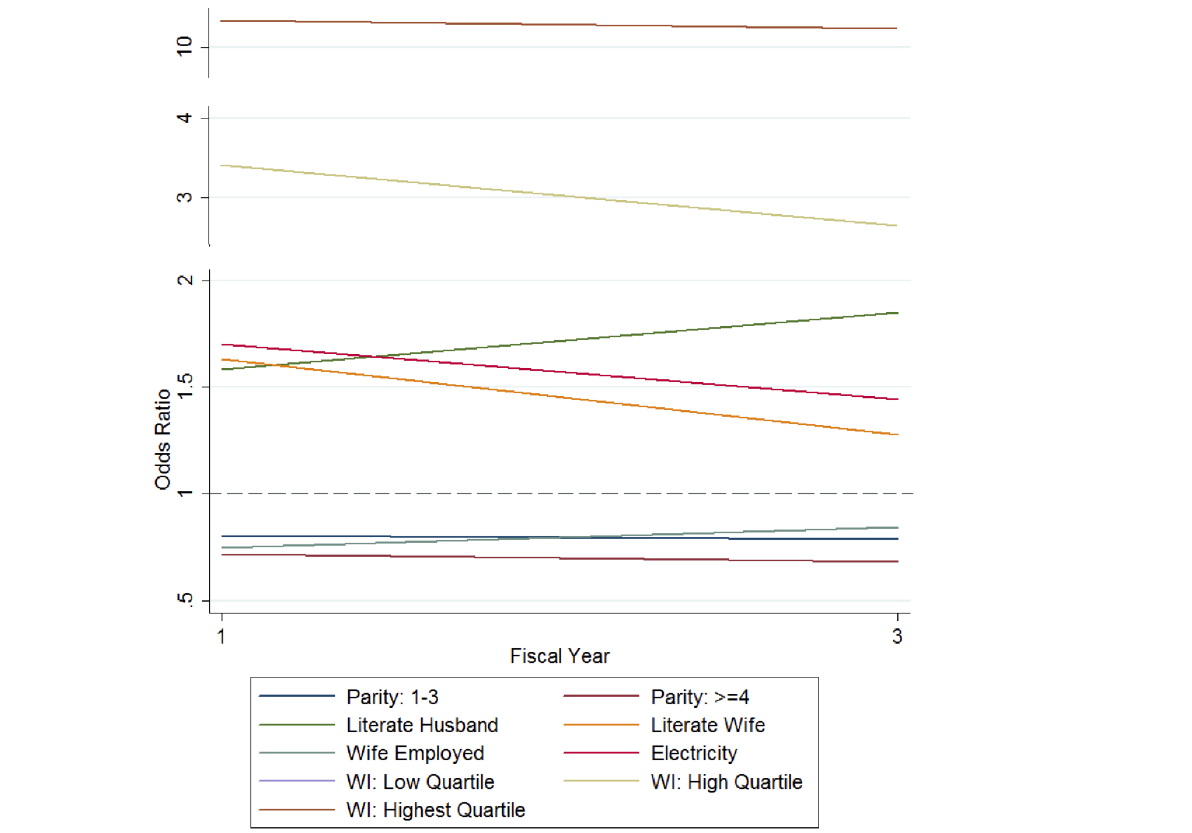
Figure 3. Odds ratio of statistically significant demographic variables ( P <.05) over fiscal years 1 and